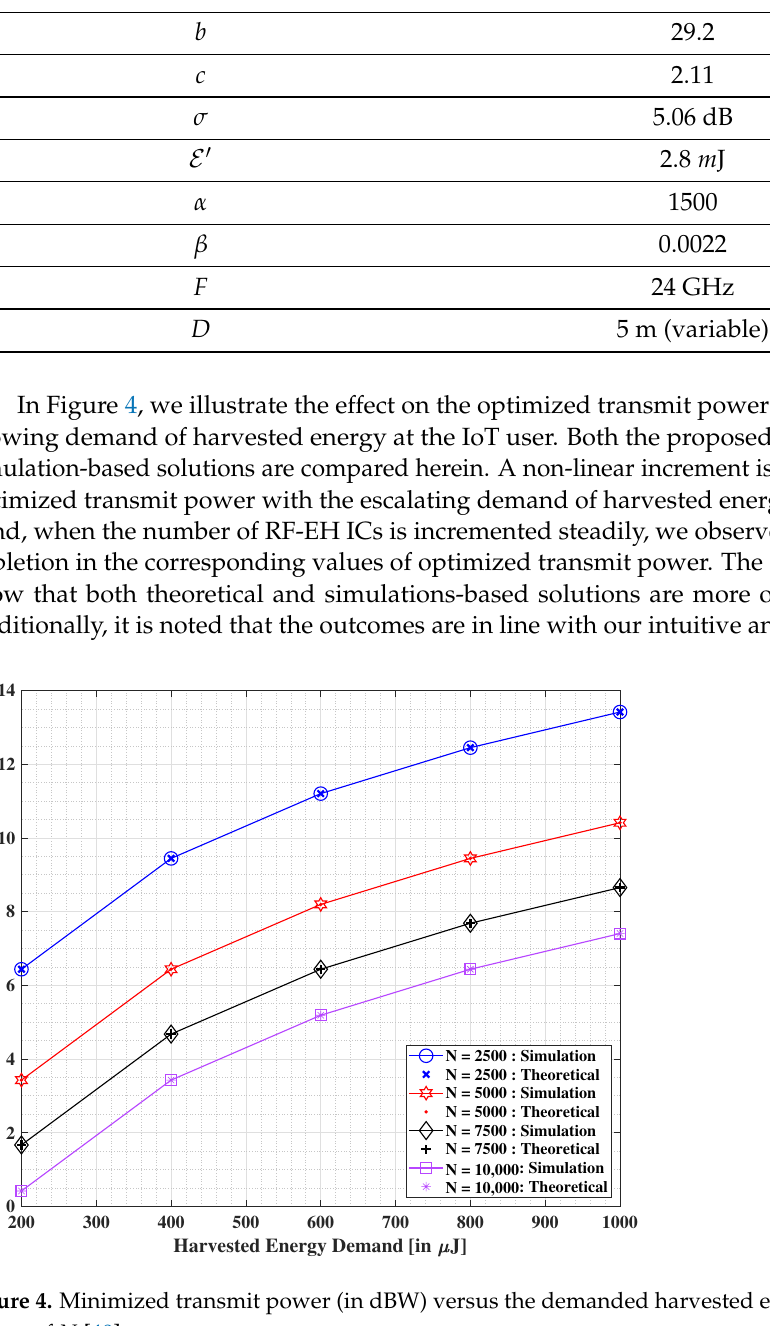
Figure 4. Minimized transmit power (in dBW) versus the demanded harvested energy for altering values of N